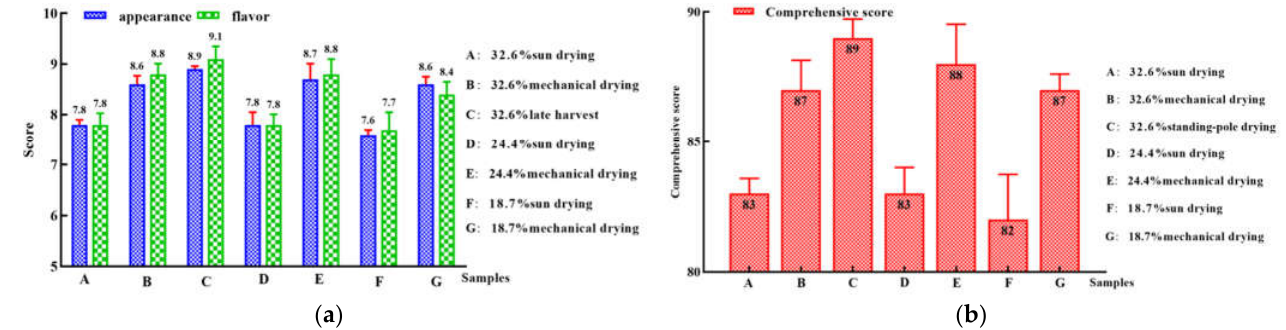
Figure 4. Comparison of the taste value of paddy after different drying methods: ( a ) appearance and flavor; ( b ) comprehensive score.